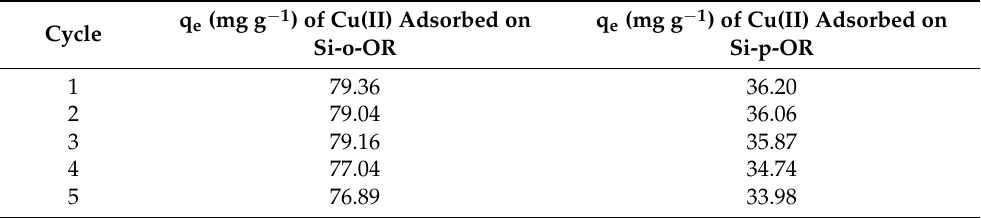
Table 5. Reusability and recycling of Si-o-OR and Si-p-OR adsorbents towards Cu(II) in repeated adsorption–desorption cycles.